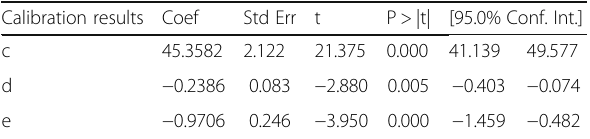
Table 4 Calibration results of linear function model Eq.(2) for cities with population densities below 1500 per/km^2 .R 2 = 0.638, sample size N = 39 Calibration results Coef